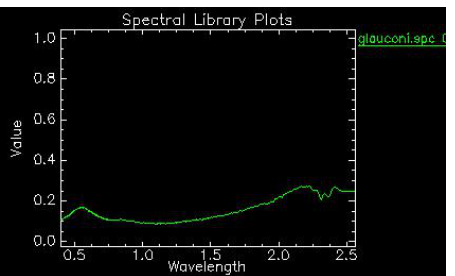
Figure 5. Spectral Library Plot for Glauconite mineral (ENVI spectral library)